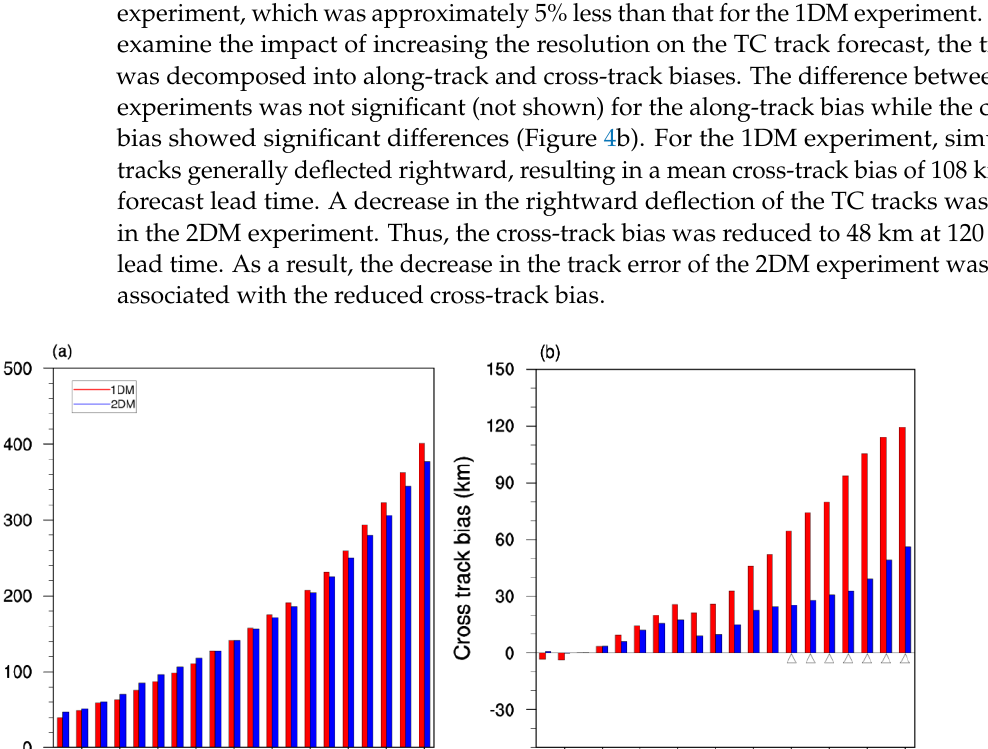
Figure 5. Mean cross-track biases (top) and scatter plots of differences between two experiments (bottom) for TCs with three intensity categories (LMI < 60 m s −1 , 60 m s −1 < LMI < 75 m s −1 , and 75 m s −1 < LMI). To find out why increasing the model resolution improves the TC track, we divided all TCs into two groups according to the difference in cross-track bias between the two experiments. The leftward shift (LS) includes the upper 25% cases with a high tendency to deflect the TC track leftward in the 2DM experiment compared to the 1DM experiment, and the non-LS includes the lower 25% cases at a 120 h forecast lead time. The overall intensity of the LS TCs is stronger than that of the non-LS TCs; the mean LMIs of LS TCs and non-LS TCs are 67.4 m s −1 and 61.2 m s −1 , respectively. In addition, the mean latitude of LS TCs is 16.1° N, which is lower than the 19.3° N of non-LS TCs. The mean cross-track bias for the lower-latitude TCs, with five-day mean center latitude below 20° N, is − 105.8 km, while that for the higher-latitude TCs, with five-day mean center latitude above 20° N, is 17.4 km. Therefore, the tendency of the TC tracks to deviate leftward in the 2DM